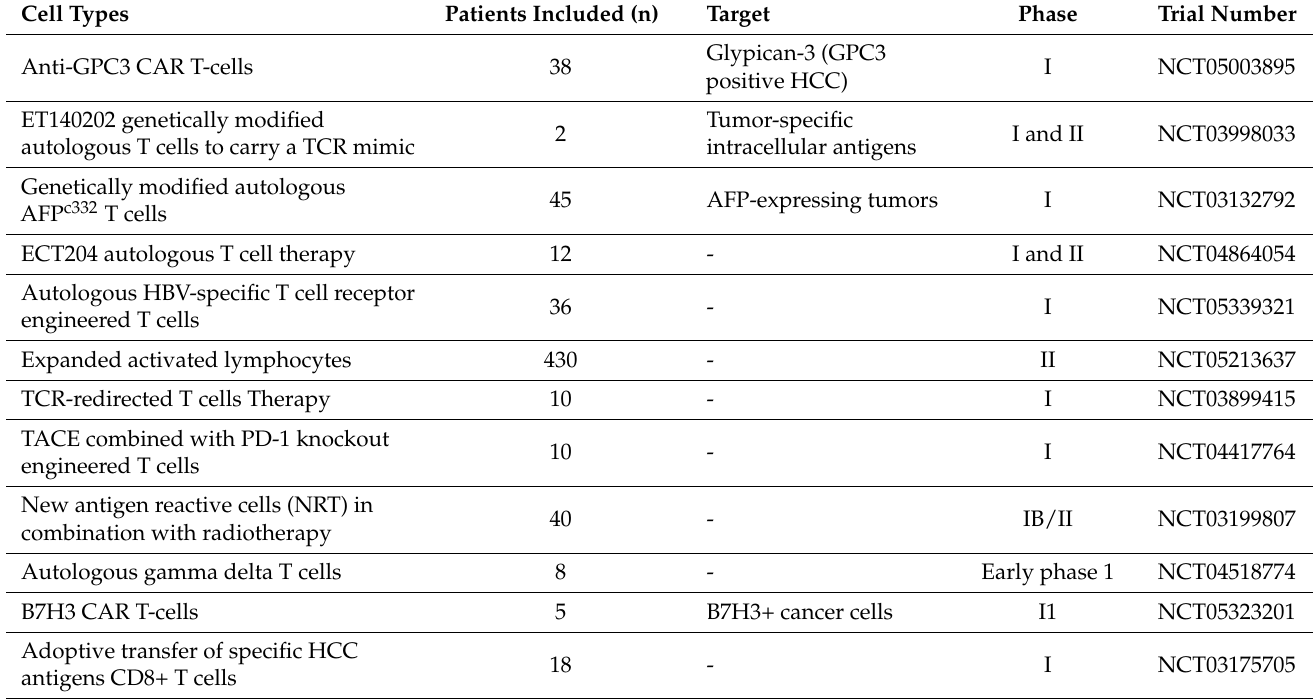
Table 1. Cell-based therapies for HCC